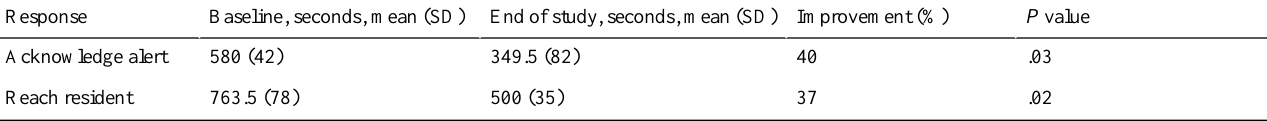
Table 5. Average acknowledgment and response times at baseline and the end of the